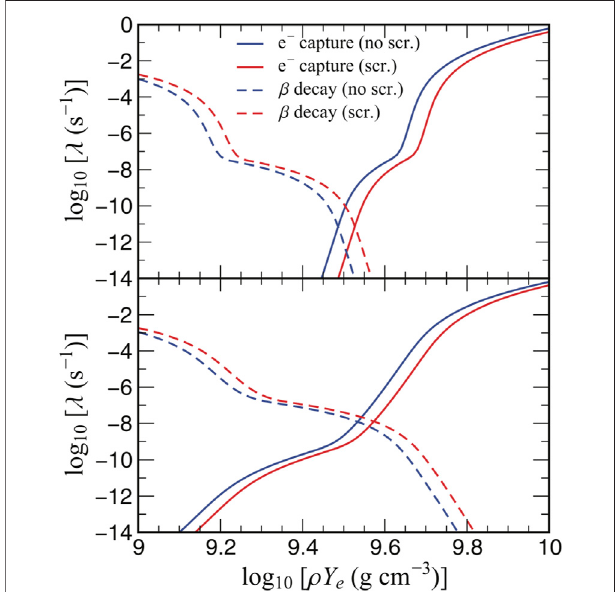
FIGURE 2 | Rates for electron capture on 20 Ne (solid) and beta decay (dashed) of 20 F for densities typical for a collapsing NeMg core of an intermediatemassstarandtworelevanttemperatures( T =4×10 8 K(top)and 10 9 K (bottom)). The rates have been calculated with and without screening corrections (red and blue lines, respectively). Due to screening, the densities at which both rates become identical are shifted to higher values. Figure reprinted with permission from